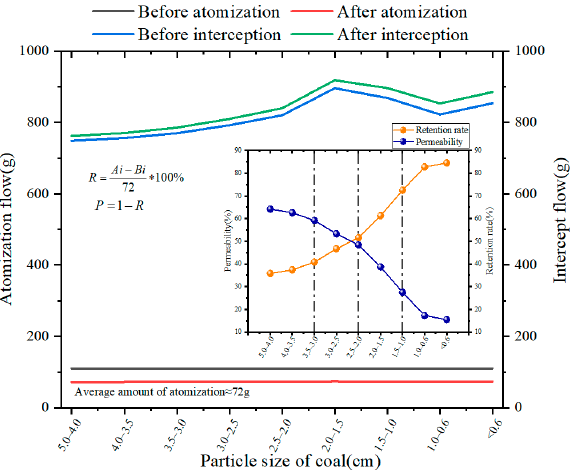
Figure 9. Aerosol diffusion effect diagram.